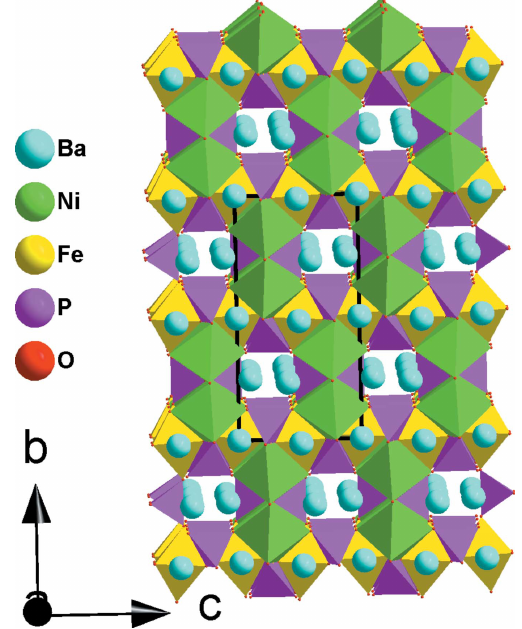
Figure 4 Polyhedral representation of the crystal structure of BaNi 2 Fe(PO 4 ) 3 showing Ba1 in the channels running along the [100] direction and a row of underoccupied Ba2 along